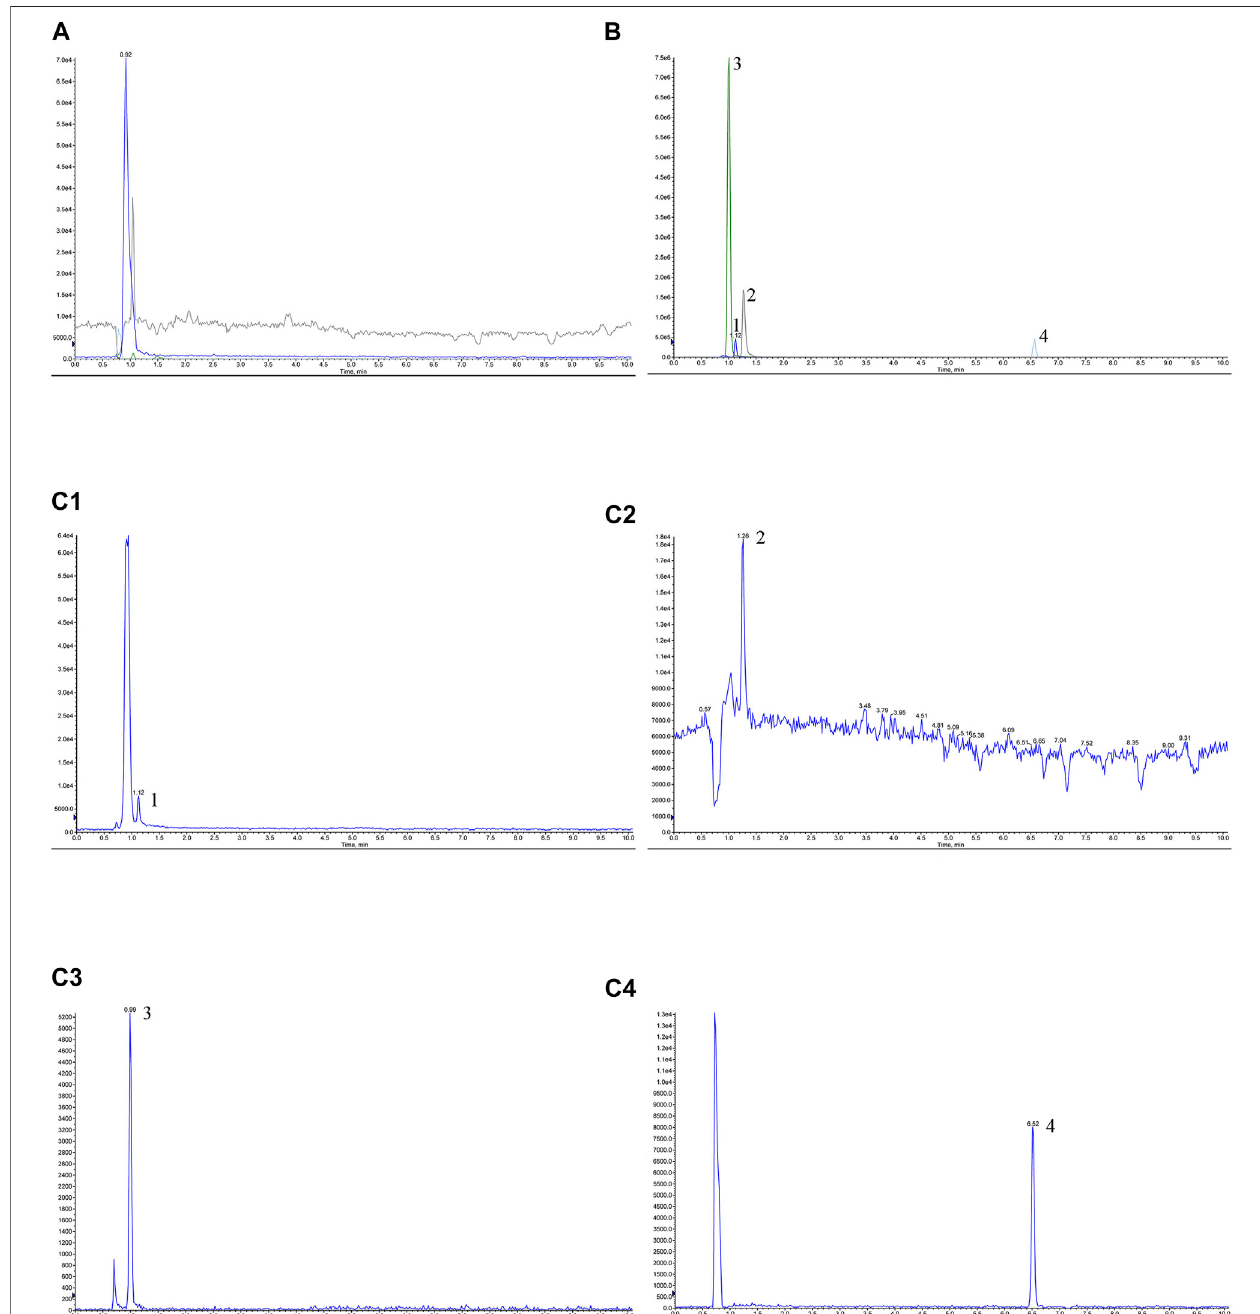
FIGURE3| Chromatogramsoftetramethylpyrazine,ferulicacid,nodakenin,andisoimperatorinofChuanxiongChatiaopowderinrabbitplasma. (A) Blankplasma, (B) control+blankplasma,and (C) post-administrationplasma. (C1) Tetramethylpyrazine, (C2) ferulicacid, (C3) nodakenin, (C4) isoimperatorin.1,tetramethylpyrazine, 2, ferulic acid, 3, nodakenin, 4,